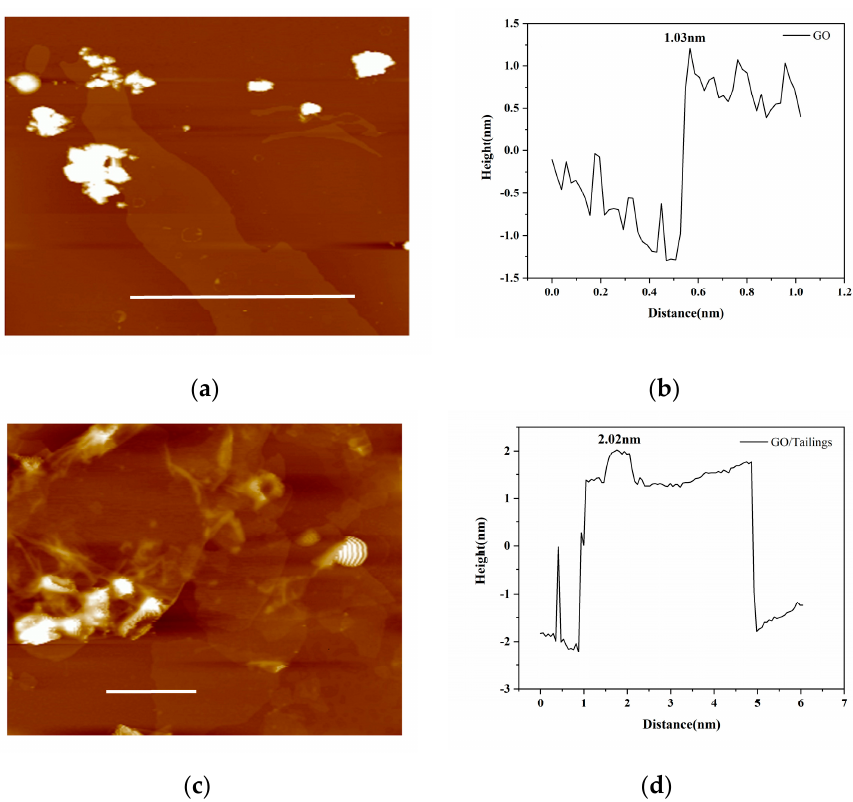
Figure 3. ( a , b ) is the AFM image of GO; ( c , d ) is the AFM image of GO/iron tailings.